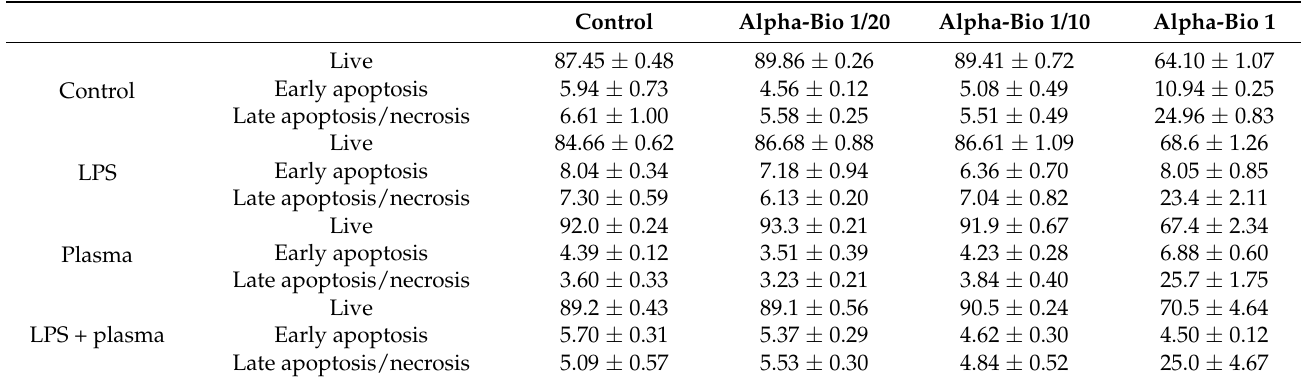
Table 4. Analysis of the viability of ТНР- 1 cells after 24 h of incubation with NSMP from the Alpha-Bio system.